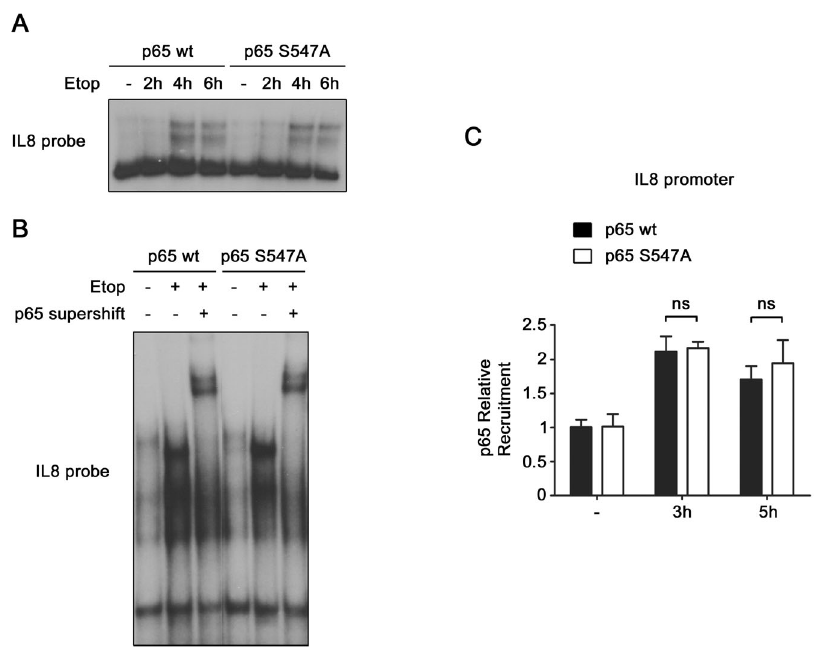
Figure 7. Identical binding of wt and S547A mutated p65 to IL8 k B site. ( A ) NF- k B binding to IL8 promoter, in HEK-293 cells expressing either p65 wt or p65 S547A , non-treated or treated with etoposide, was analyzed by EMSA with a probe corresponding to the k B site of IL8 promoter. ( B ) The presence of p65 protein in the binding complex observed in ( A ) was analyzed by supershift with p65 antibody. ( C ) Recruitment of p65 on IL8 promoter was measured by p65 ChIP assay in HEK-293 cells expressing either p65 wt or p65 S547A , and treated with etoposide for the indicated periods. ns, non significantly